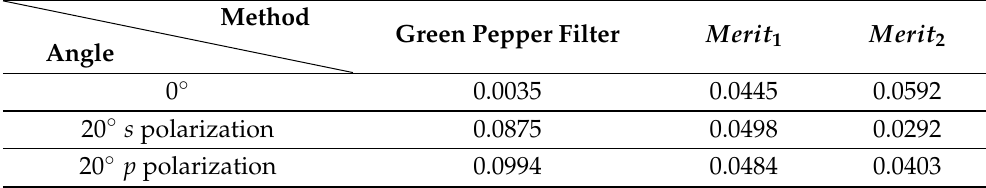
Table 1. Mean absolute error of the Green Pepper Filter and the proposed methods compared to the target